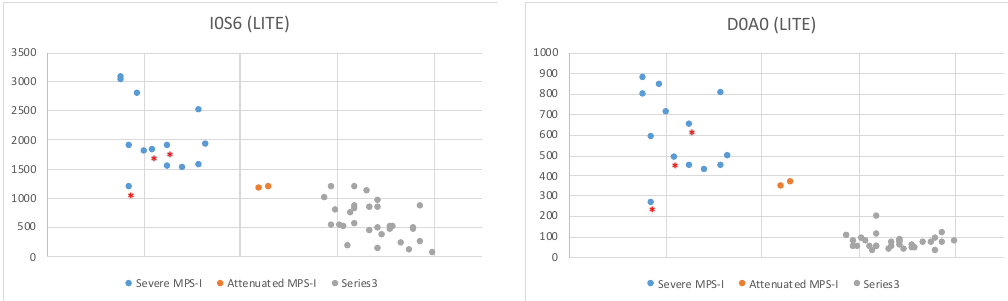
Figure 7. Same as Figure 6 except Sensi-Pro lite was used. See Figure 2 legend for an explanation of the singe random newborn with high biomarker levels. Asterisked dots are from newborn DBS that were stored at ambient temperature, all others were stored frozen.